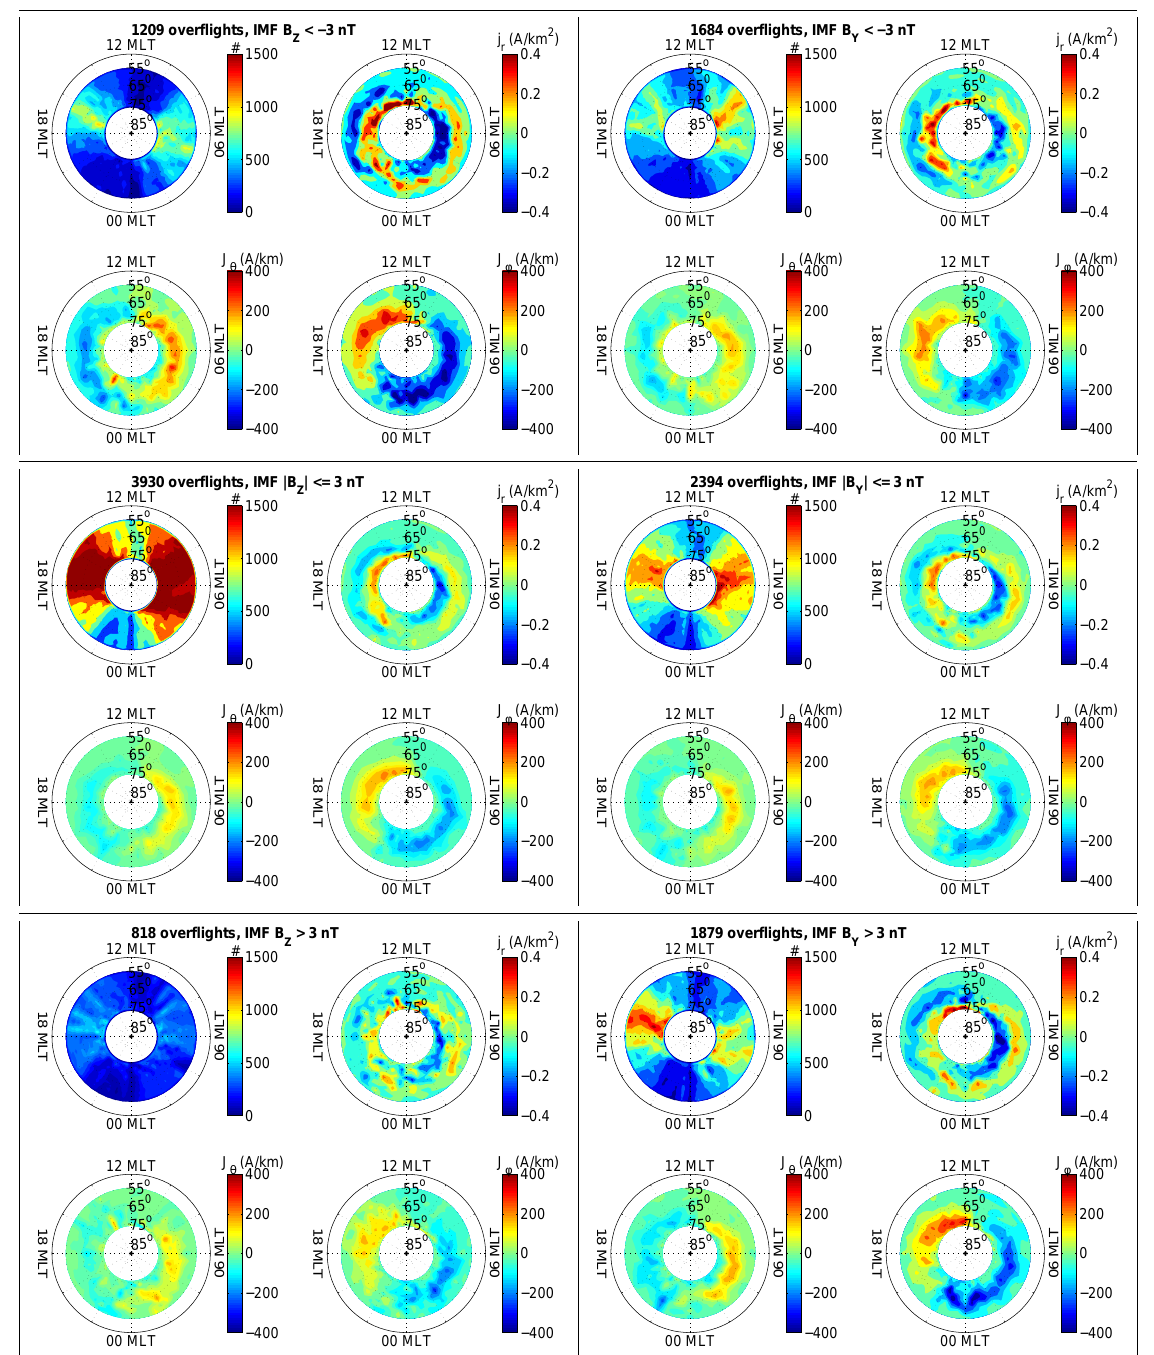
Fig. 12. The same as Fig. 10, except that the data are binned with respect to the IMF B Z and B Y . There are bins for negative ( < − 3 nT ), around zero ( < | 3 | nT ) and positive ( > 3 nT ) values of both components. The bin and the number of overpasses used to construct the four plots are denoted on top of each set.